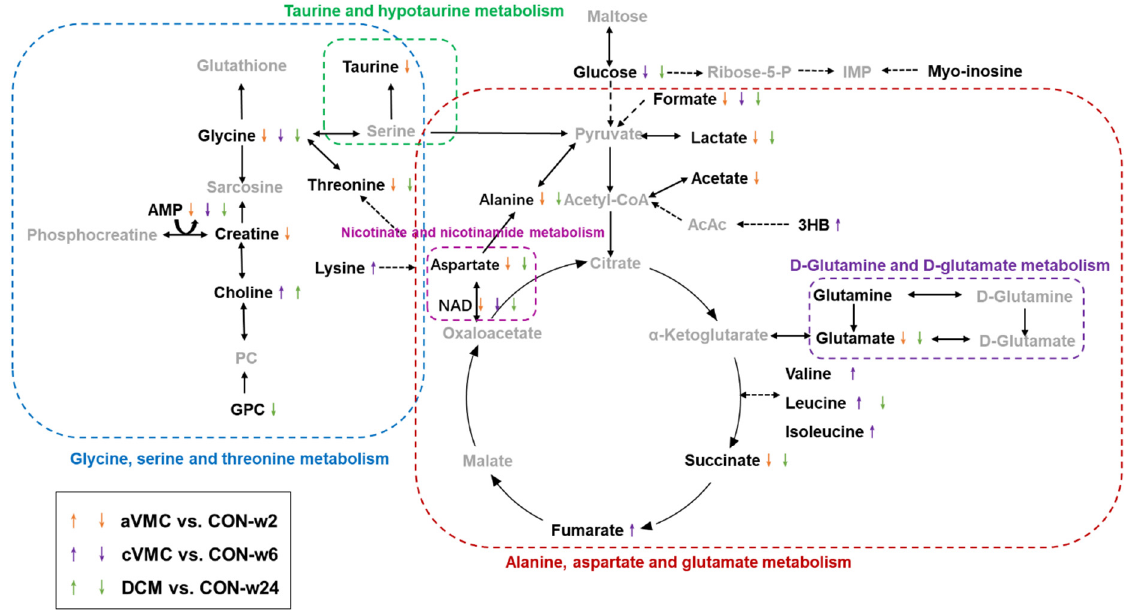
Figure 4. Overview of significantly impaired metabolic pathways involved in the three pathological stages compared with normal controls. The up/down arrows indicate significantly increased/decreased metabolites; dashed/solid arrows represent multi-step/single-step reactions.